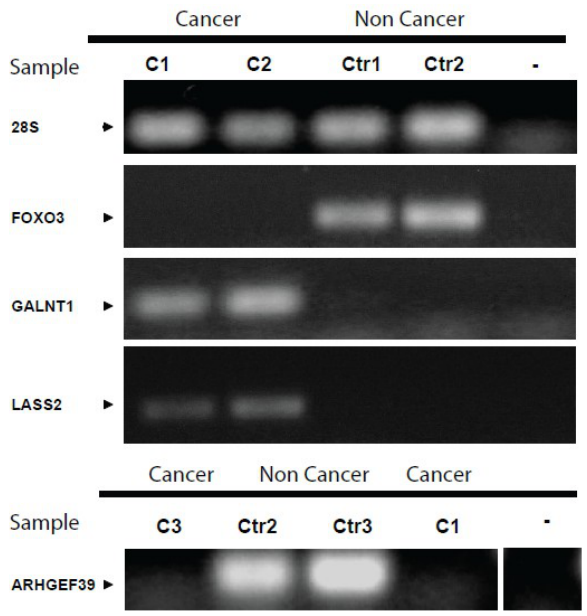
Figure 3. PCR amplification of selected genes in cancer and non-cancer samples. Urinary EVs from cancer patients did not contain FOXO3 or ARHGEF39 . However, GALNT1 and LASS2 transcripts were present. The opposite result was obtained for samples isolated from non cancer patients. 28S rRNA transcript was detected in all